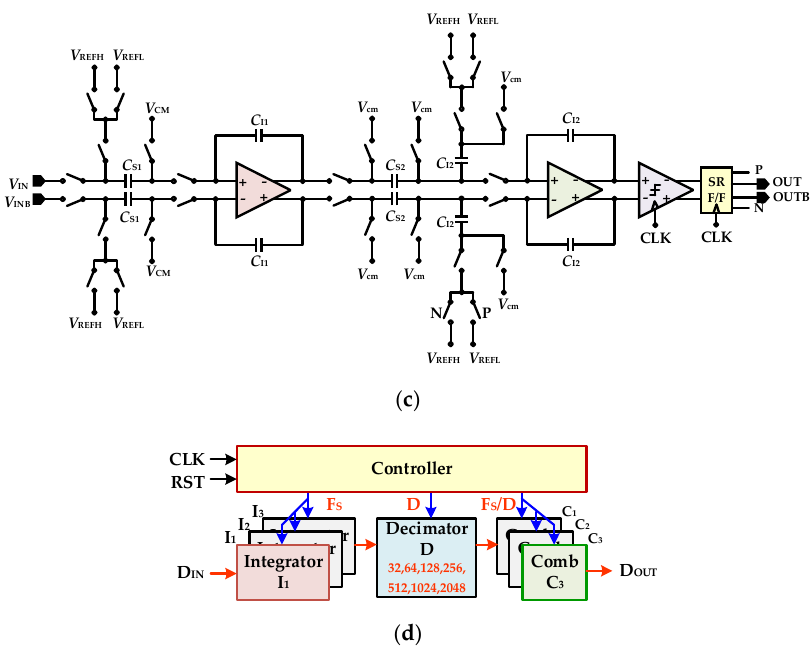
Figure 7. Sigma-Delta analog-to-digital converter (ADC): ( a ) block diagram with sigma-delta modulator (SDM) and reconfigurable decimation filter (RDF); ( b ) second order SD-ADC block diagram; ( c ) second order SD-ADC circuit diagram; ( d ) reconfigurable decimation filter (RDF) architecture.